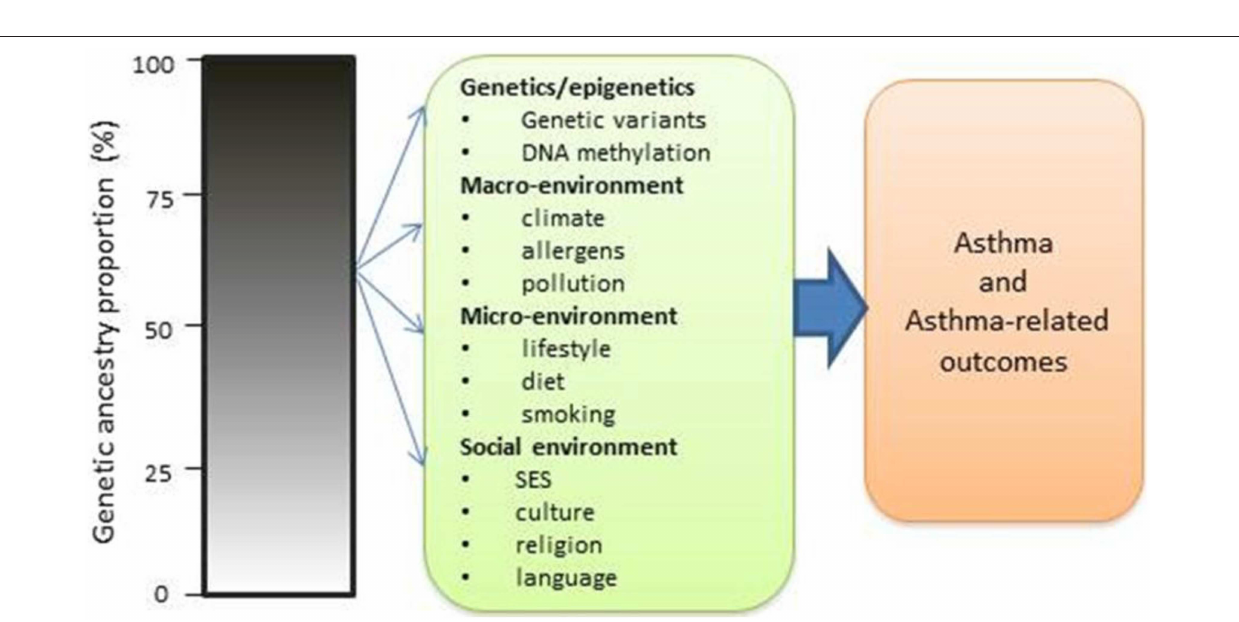
FIGURE 7 | Impact of ancestry with both genetic and non-genetic risk factors in causing asthma and asthma-related risks.